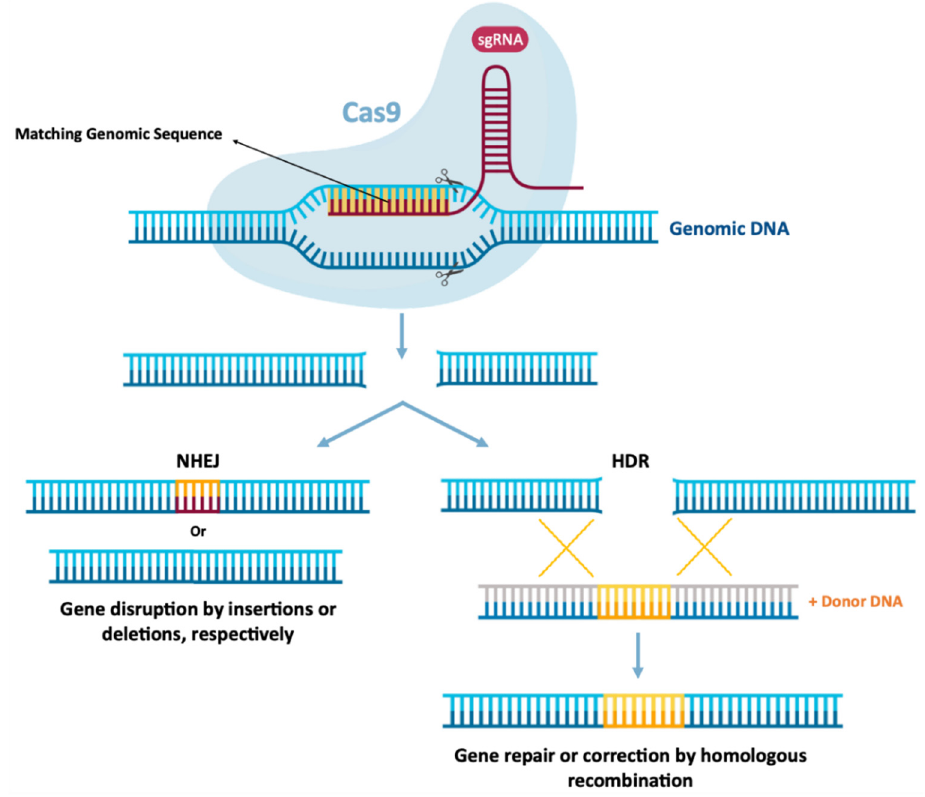
Figure 9. Schematic of CRISPR-Cas9-mediated genome editing. A CRISPR-Cas9 endonuclease is directed to a DNA sequence by means of a single guide RNA sequence (sgRNA), resulting in double strand cleavage. Subsequently they are repaired by non-homologous final union (NHEJ) or homology-directed repair (HDR). NHEJ repair provides errors, often leads to insertion or deletion mutations, which can lead to genome instability. Alternatively, in the presence of an exogenous donor DNA model, it can be repaired through error-free HDR, projecting precise DNA changes.